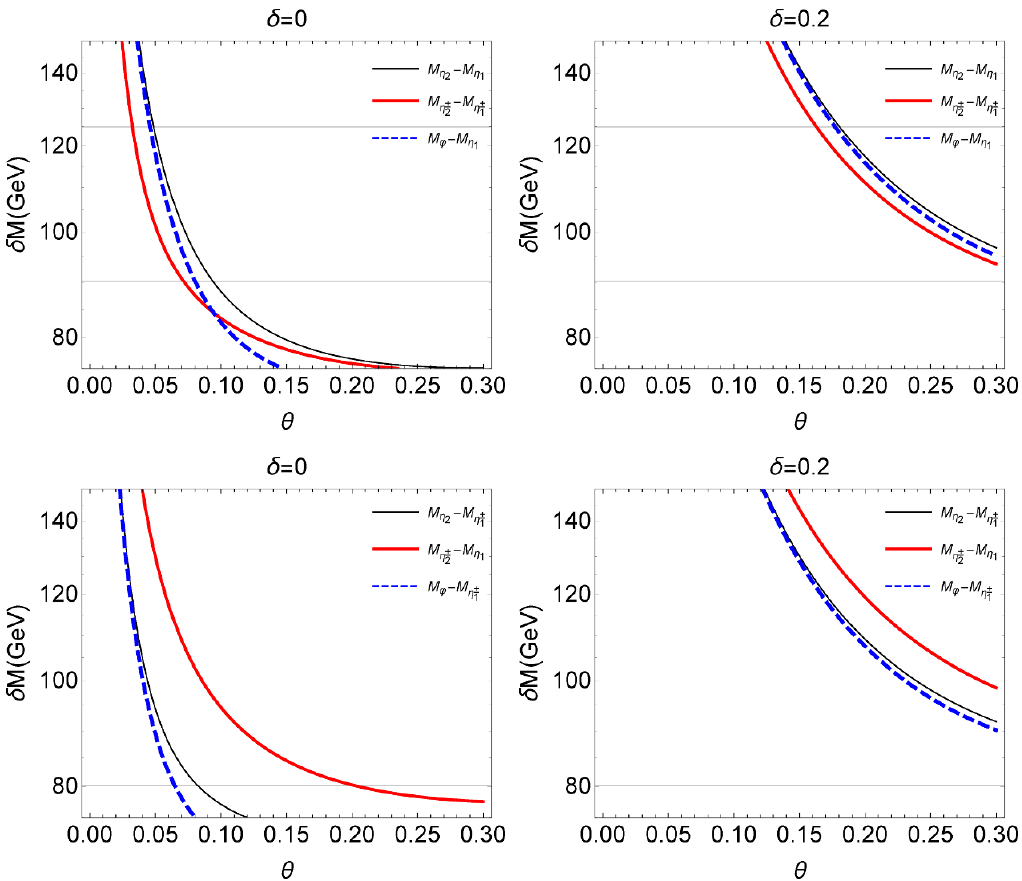
Figure 1 . Mass di(cid:11)erences between the DM-odd pNGBs of the tier 2 and tier 1, for (cid:14) = 0 (left column) and (cid:14) = 0 : 2 (right column). In the plots at the top row, the two grey lines correspond to the masses of Higgs and Z (cid:22) respectively. In the plots at the bottom row, the grey line corresponds to the mass of W (cid:6) (cid:22)